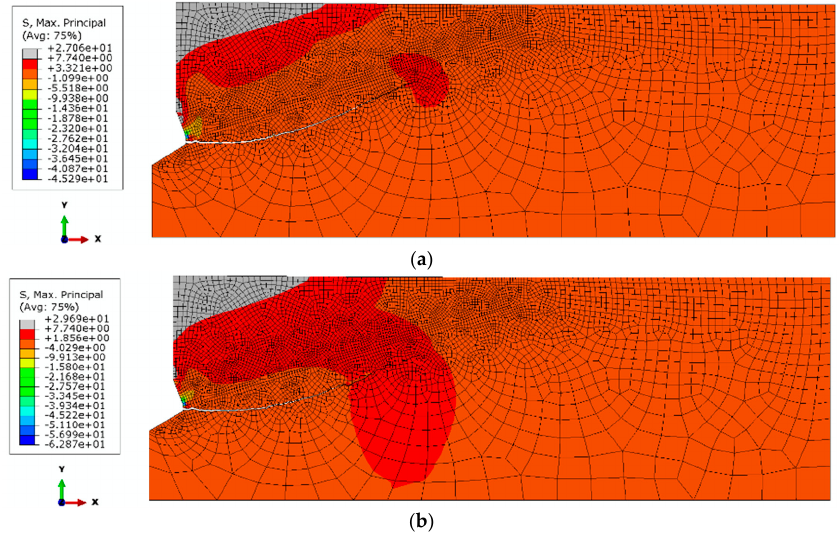
Figure 6. Initial course of damage propagation and distribution of maximum stresses for: E II = 9287 MPa, μ = 0.4; β = 20° and Poisson’s Ratio, ( a ) ν 3 = 0.25; ( b ) ν 4 = 0.30. It can be seen from Figure 6 that an increase in Poisson’s ratio from ν = 0.25 to 0.30